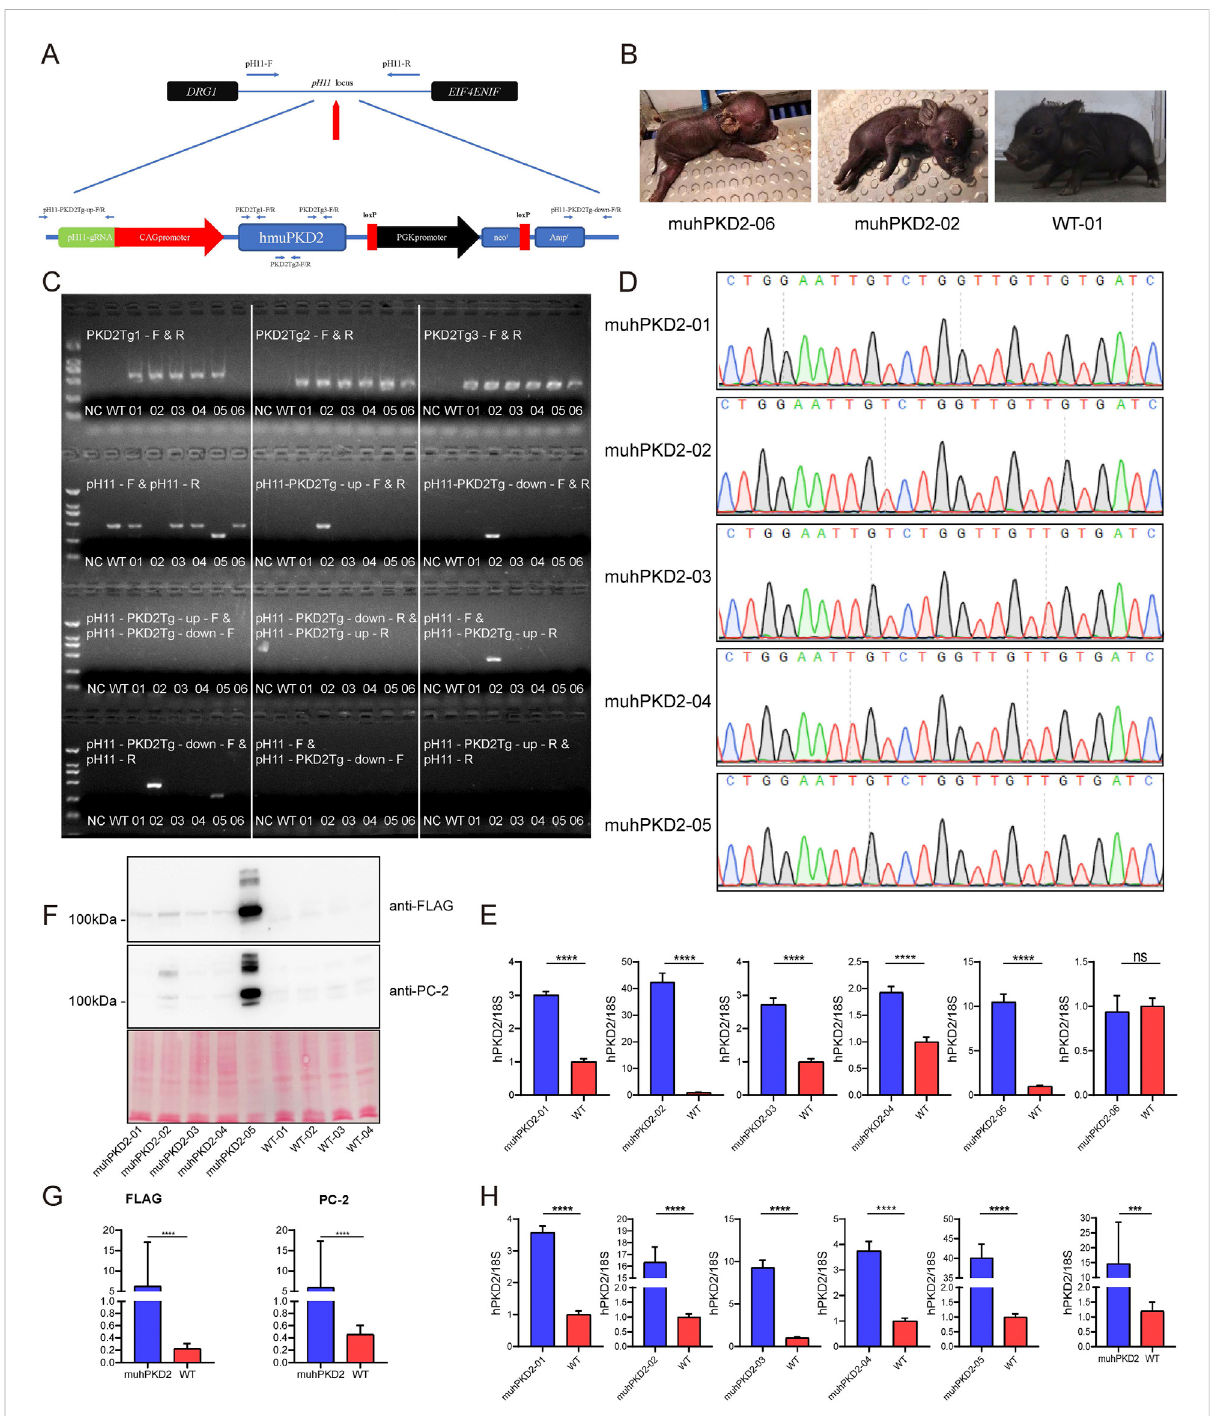
FIGURE 2 Overexpression of hPKD2-D511V resulted in postnatal deaths of the pigs. (A) The schematic representation of insertion of the transgene vector to pH11 safe harbor by the non-homologous end joining mediated targeted insertion. (B) Photos of newborn cloned pigs. (C) The results of PCR identi fi cation. (D) Sequencing analyses of cloned pigs using primers PKD2Tg1-F/R. (E) The mRNA levels of hPKD2 in the skin tissues of different cloned pigs. (F,G) Western blot analysis of FLAG and PC-2 in the cloned pig kidney tissues. Ponceau S staining was used as a loading control in the measurements. (H) The mRNA levels of hPKD2 in the kidney tissues of different cloned pigs. The relative mRNA expression and membrane protein expression levels from the WT group were used as the reference values, and * indicates that there were signi fi cant differences between the two groups. Results were expressed as mean ± SEM ( n =